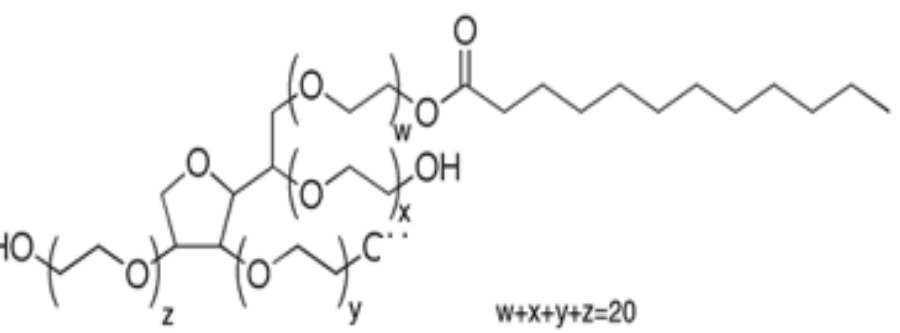
Figure 2. The structure of Tween 20 (W + X + Y + Z = 20) with primarily (60%) C12 alkyl chains; molar mass 1228. Tween 40, also with (W + X + Y + Z = 20), has primarily (90%) C16 alkyl chains; molar mass 1277. Table 1. List of cinnamic acid derivatives with their corresponding acid dissociation constant